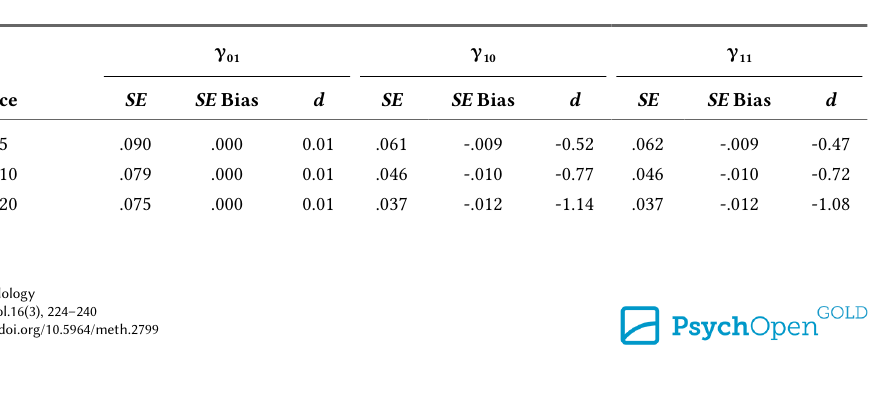
Bias Statistics for the Standard Error Differences in the Parameter Estimates Between a Model With a Fixed Slope and a Model With a Slope Allowed to Vary Source